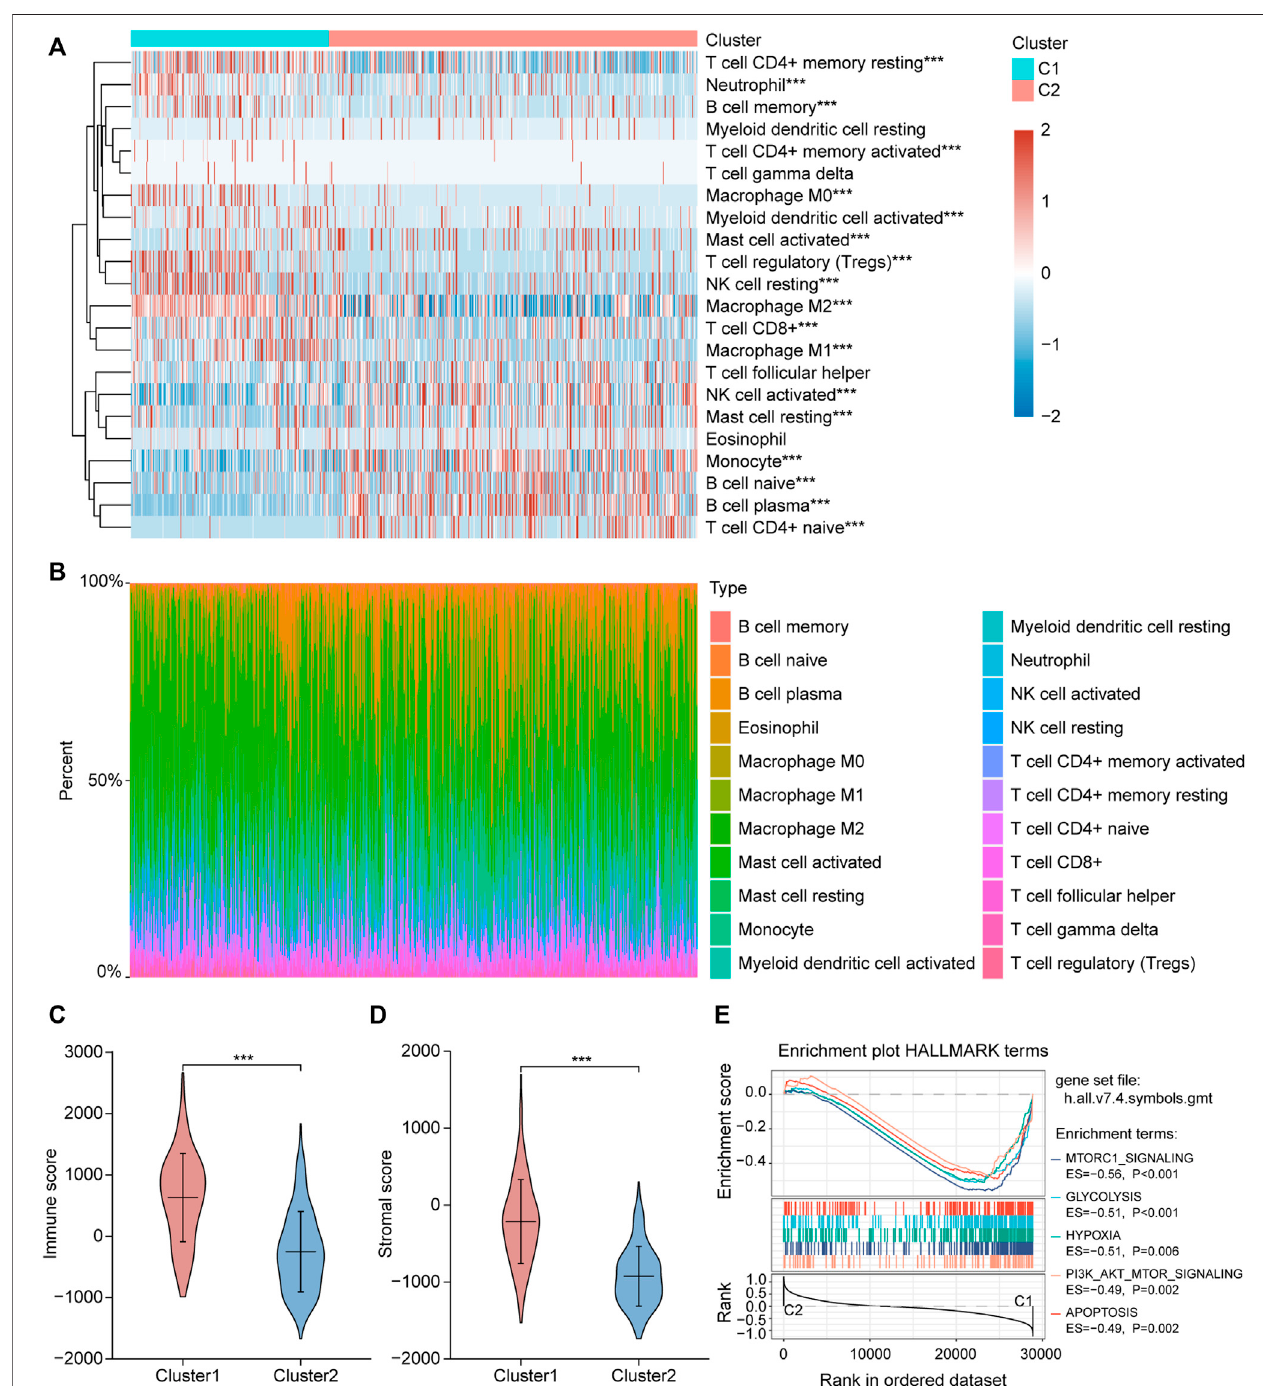
FIGURE 4 | Different immune cell in fi ltration between two ferroptosis-related subtypes. (A) Immune cell score heat map, where different colors represent the expression trend in each sample between two ferroptosis-related subtypes. * p < 0.05, ** p < 0.01, *** p < 0.001. (B) The percentage abundance of tumor in fi ltrating immune cells in each sample, with different colors and different types of immune cells. The abscissa represents the sample, and the ordinate represents the percentage of immune cell content in a single sample. (C,D) Violin plots of the immuneScore and stromalScore between the two ferroptosis-related subtypes. * p < 0.05, ** p < 0.01, *** p < 0.001. (E) The enrichment plots of representative Gene Set Enrichment Analysis (GSEA) results. ES, enrichment score.